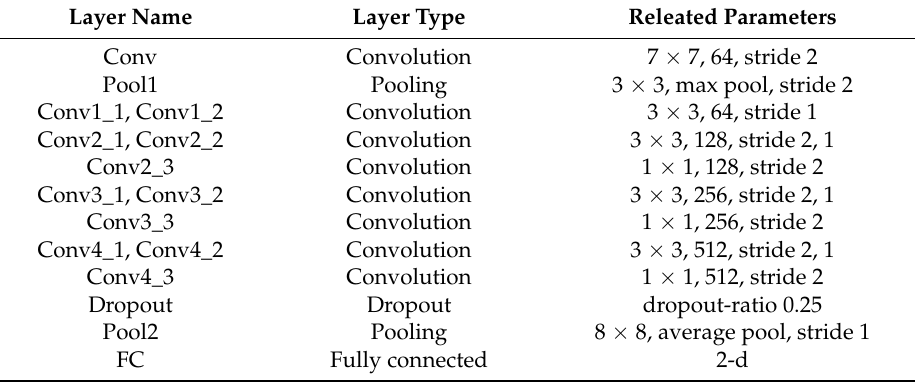
Figure 9. The architecture of SR-CNN. Table 4. The parameter of model SR-CNN, C represents the output channel number of the SE-Res